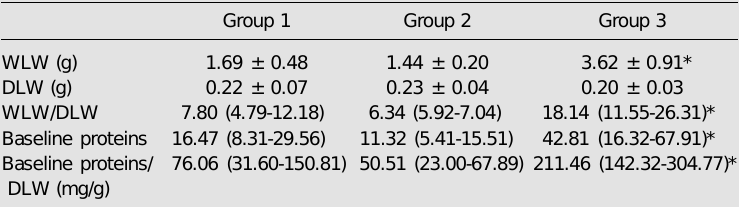
Table 3. Wet lung weight (WLW), dry lung weight (DLW), WLW/DLW ratio, baseline protein contents, and baseline protein contents/DLW